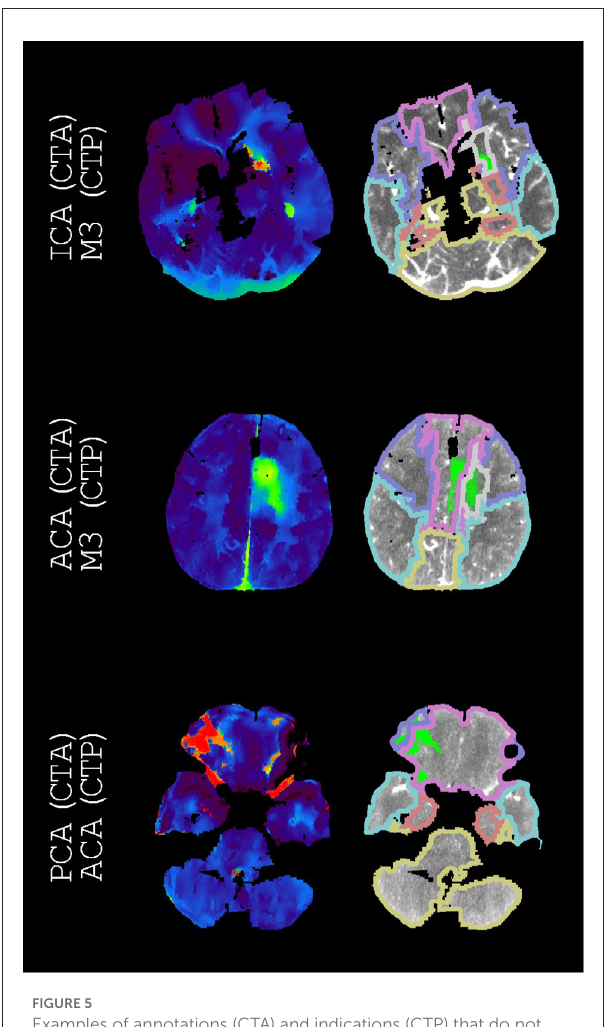
FIGURE5 Examples of annotations (CTA) and indications (CTP) that do not match arteries other than the middle cerebral artery. On the left, time-to-peak perfusion maps are shown. On the right, the hypoperfused regions and the downstream regions (according to Figure 1) are shown. For each example, we only regarded the M3 downstream region with the highest intersection-over-union. If displayed, these M3 downstream regions are the frontal white matter and the frontal white matter (from top to bottom). The second-best indications were M2, ACA, and M2 (from top to